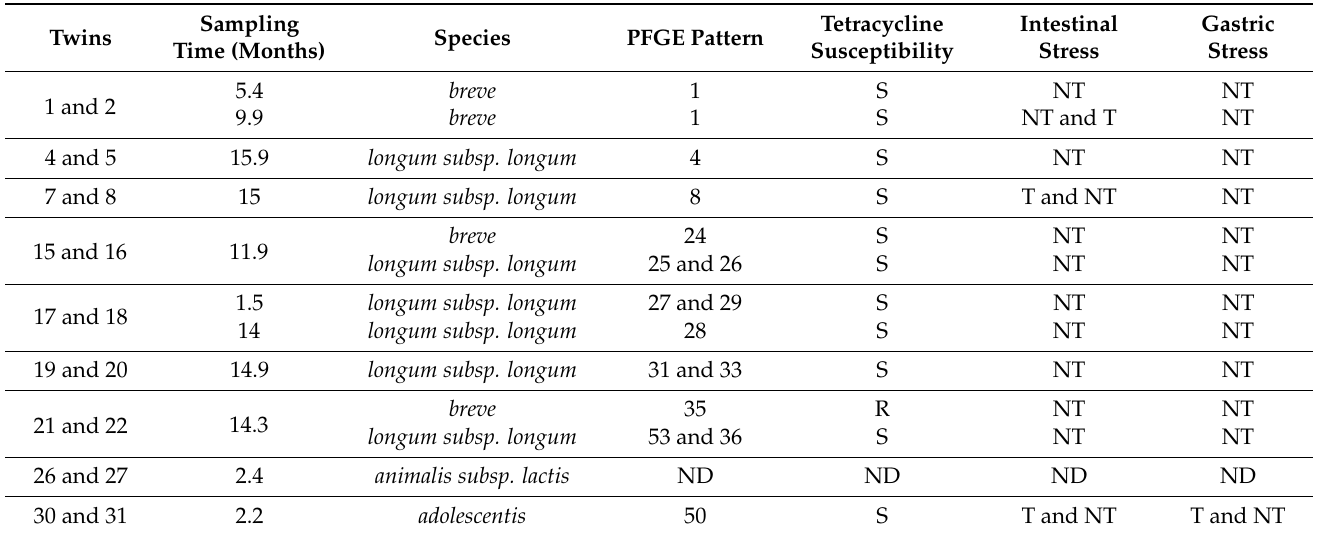
Table 4. Characteristics of strains found in feces of twins with same species at the same